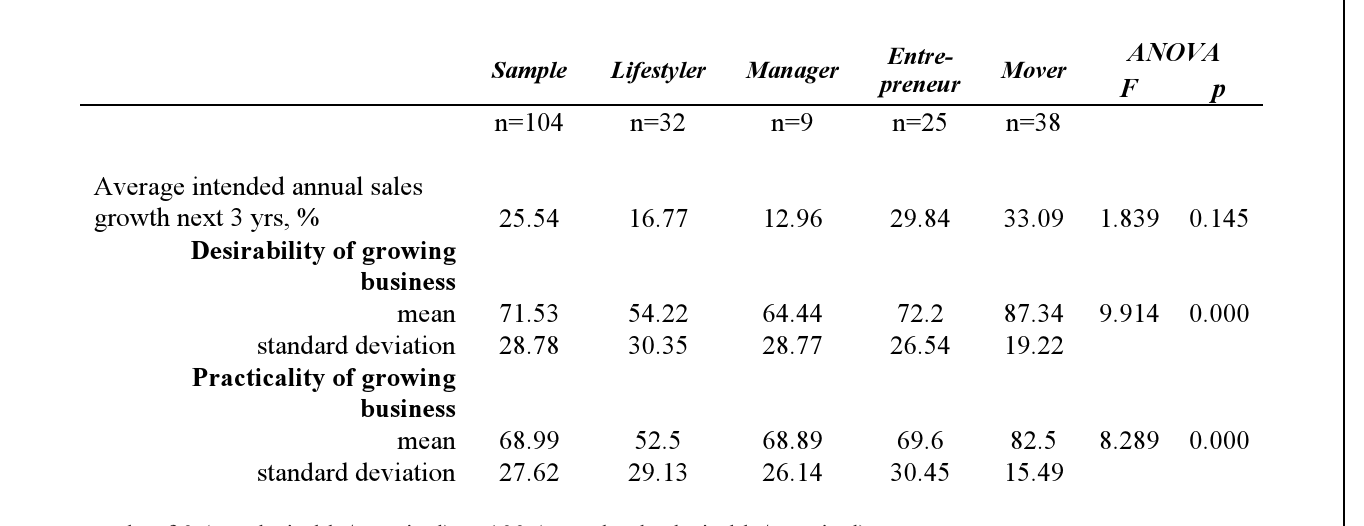
Table 2. ANOVA on Desirability and Practicality of Growing the Business